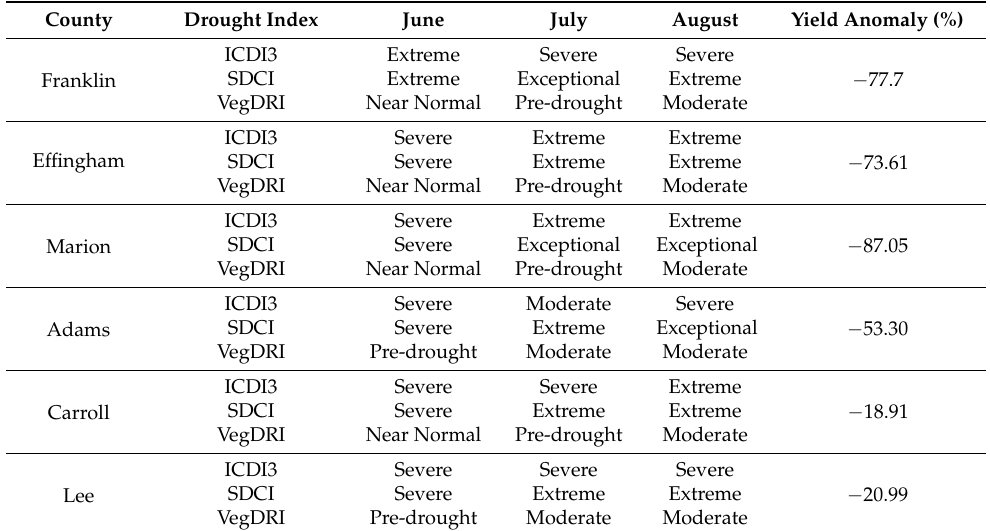
Table 7. Drought indices in summer and the corn yield anomalies in